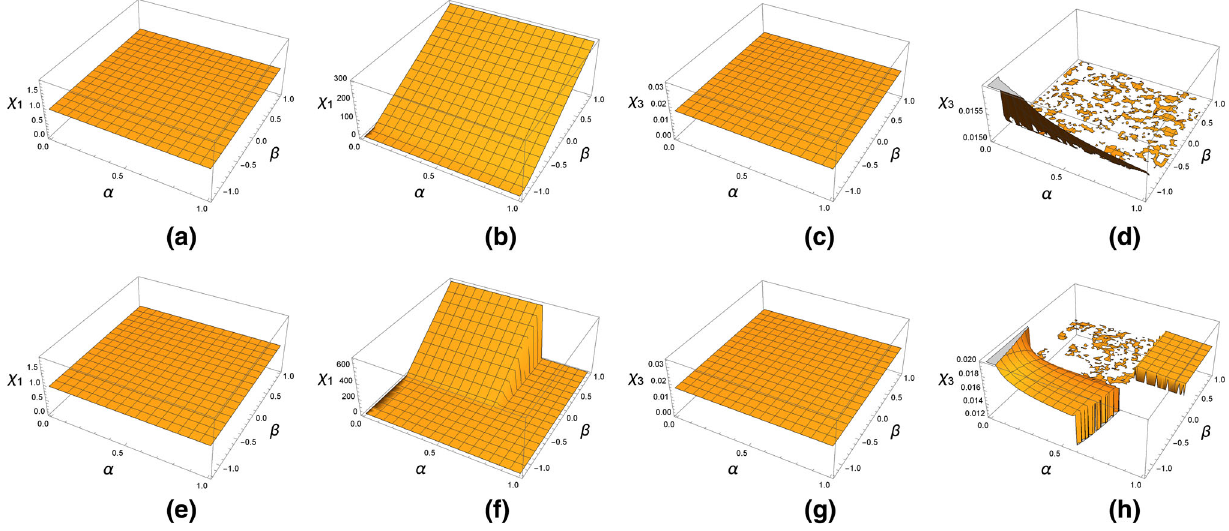
Fig. 2 The figure depicts the snapshots at time t = 1 . 0 and t = 100 . 0 for the evolution of the event horizon χ 3 and of the cosmological hori- zon χ 1 in a , b , e , f and c , d , g , h respectively of the McVittie spacetime.